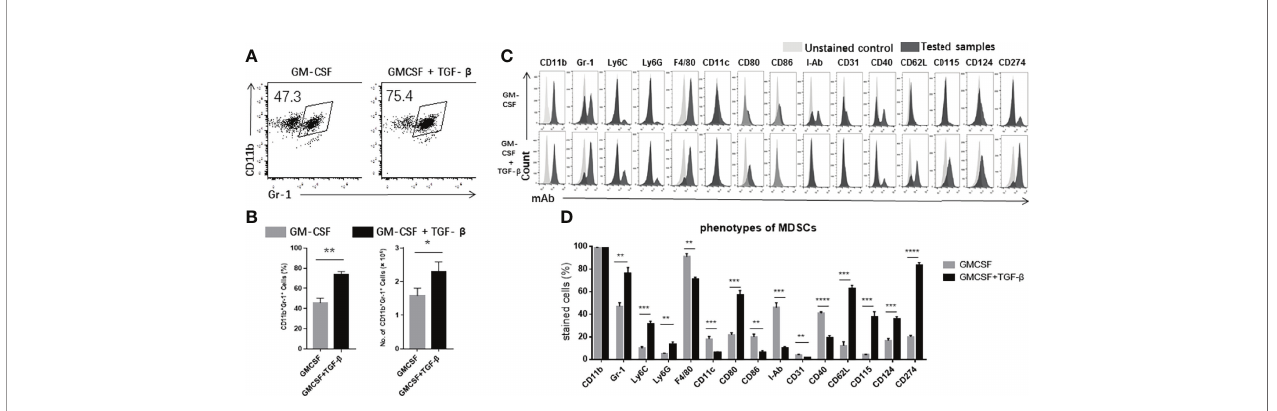
FIGURE 1 | The characteristics of TGF- b + GM-CSF – induced MDSCs. (A) The precursor cells from the bone marrow cells were cultured in GM-CSF alone or TGF- b + GM-CSF as described in Materials and Methods for 4 days. The percentages of CD11b + Gr-1 + MDSCs have been shown by FCM analysis. (B) The proportions and numbers of CD11b + Gr-1 + MDSCs that were induced by either GM-CSF alone or TGF- b + GM-CSF. (C) FCM analysis showed the typical phenotypes of the cells stained by FITC-, PE-, PE-Cy5 – , or APC-labeled anti-mouse-CD11b, Gr-1, Ly6C, Ly6G, F4/80, CD11c, CD80, CD86, I-Ab, CD31, CD40, CD62L, CD115, CD124, and CD274 Abs. (D) The proportions of the indicated markers have been summarized. The data have been shown as mean ± SEM (n = 3) and were analyzed by an unpaired two-tailed Student ’ s t-test, which were collected from three independent experiments. P < 0.05 was considered as statistically signi fi cant between the groups. * P < 0.05, ** P < 0.01, and *** P < 0.001 upon comparison between the two